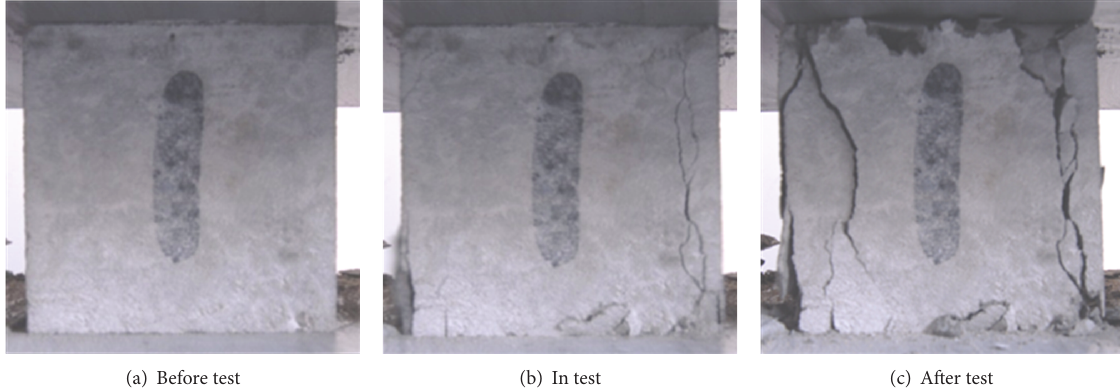
Figure 6: Failure process of recycled concrete in marine environment.